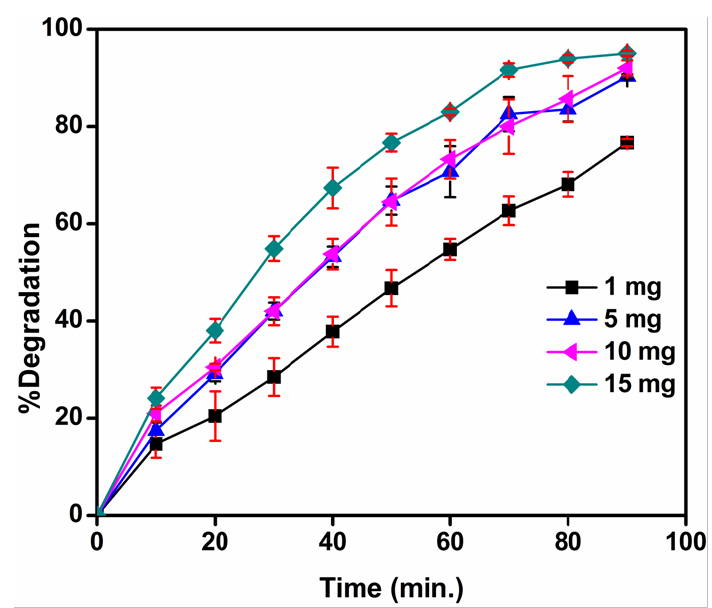
Figure 13. UV-visible spectra of MB dye (10 − 5 M) with different amounts of catalyst loading. Data obtained by degradation versus time are average values of three independent experiments (reported values = mean ± S.D.)